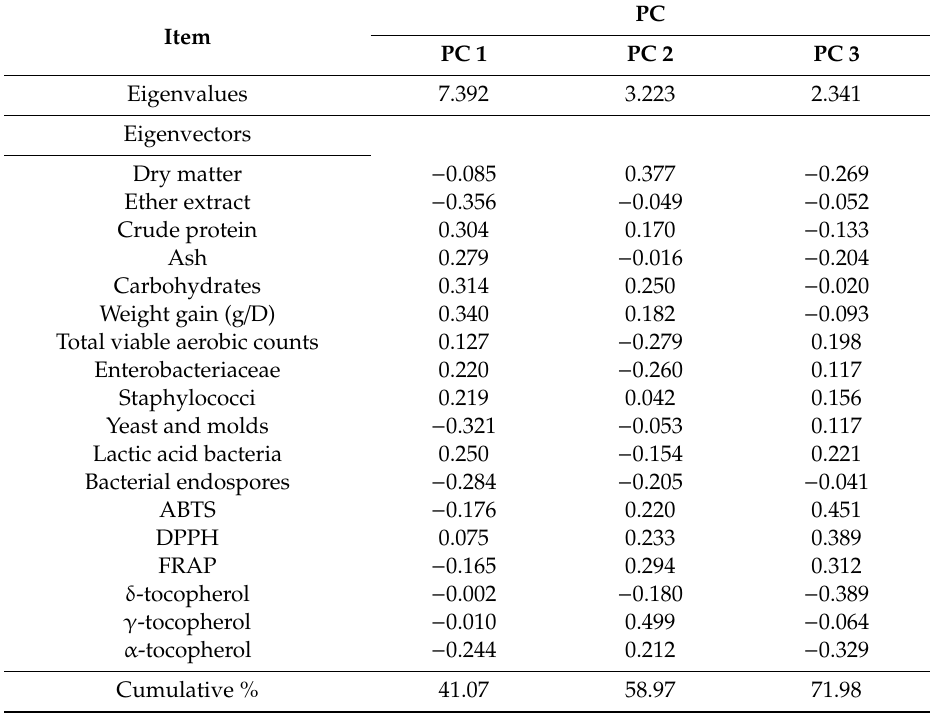
Table 5. Eigenvalues and eigenvectors of the first three principal components (PC) of principal components analysis performed on proximate composition, microbial loads, growth performance, antioxidant capacity, and antioxidant compounds of mealworm larvae fed experimental